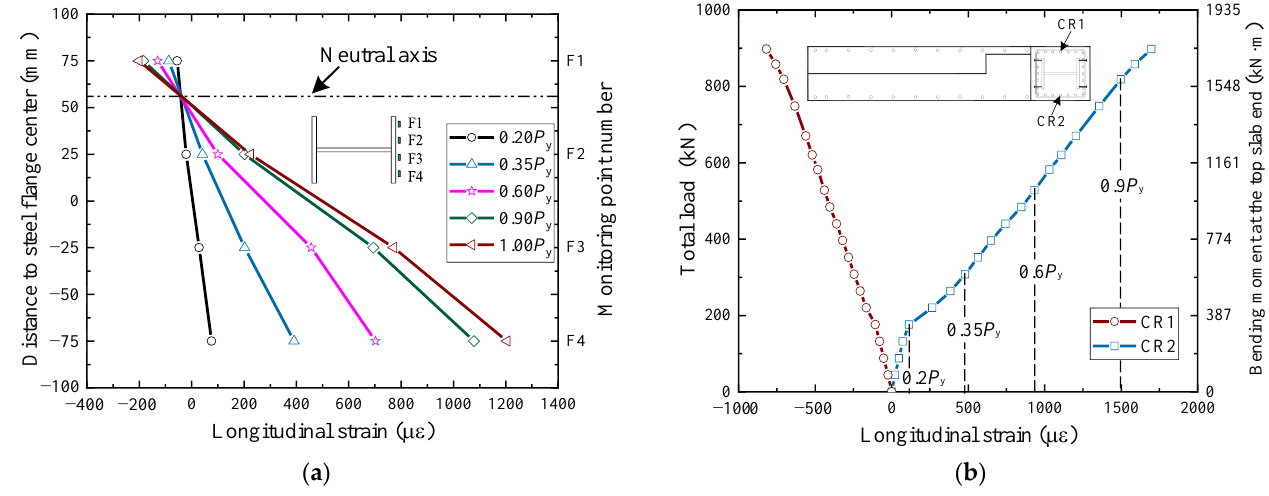
Figure 13. Strains development in the SRC column: ( a ) typical strain distribution along the flange and ( b ) load–strain curves of the longitudinal rebars.